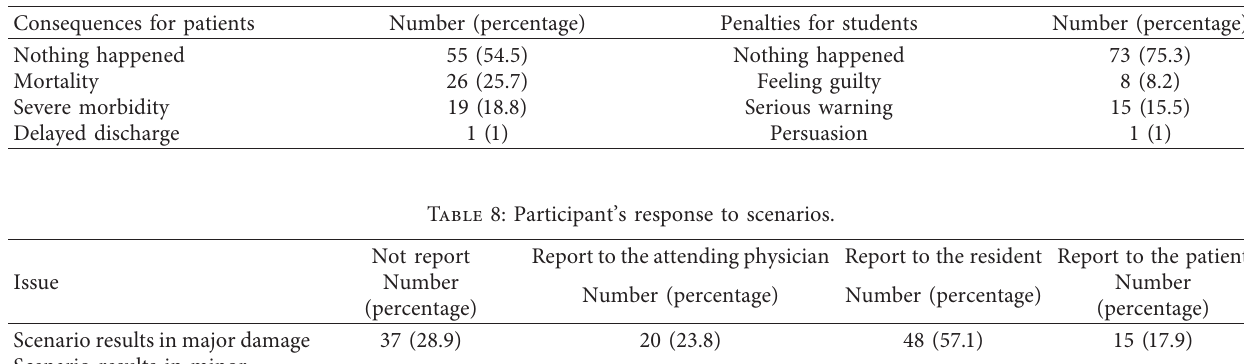
Table 7: Consequences and penalties after students’ failure to report a medical error.